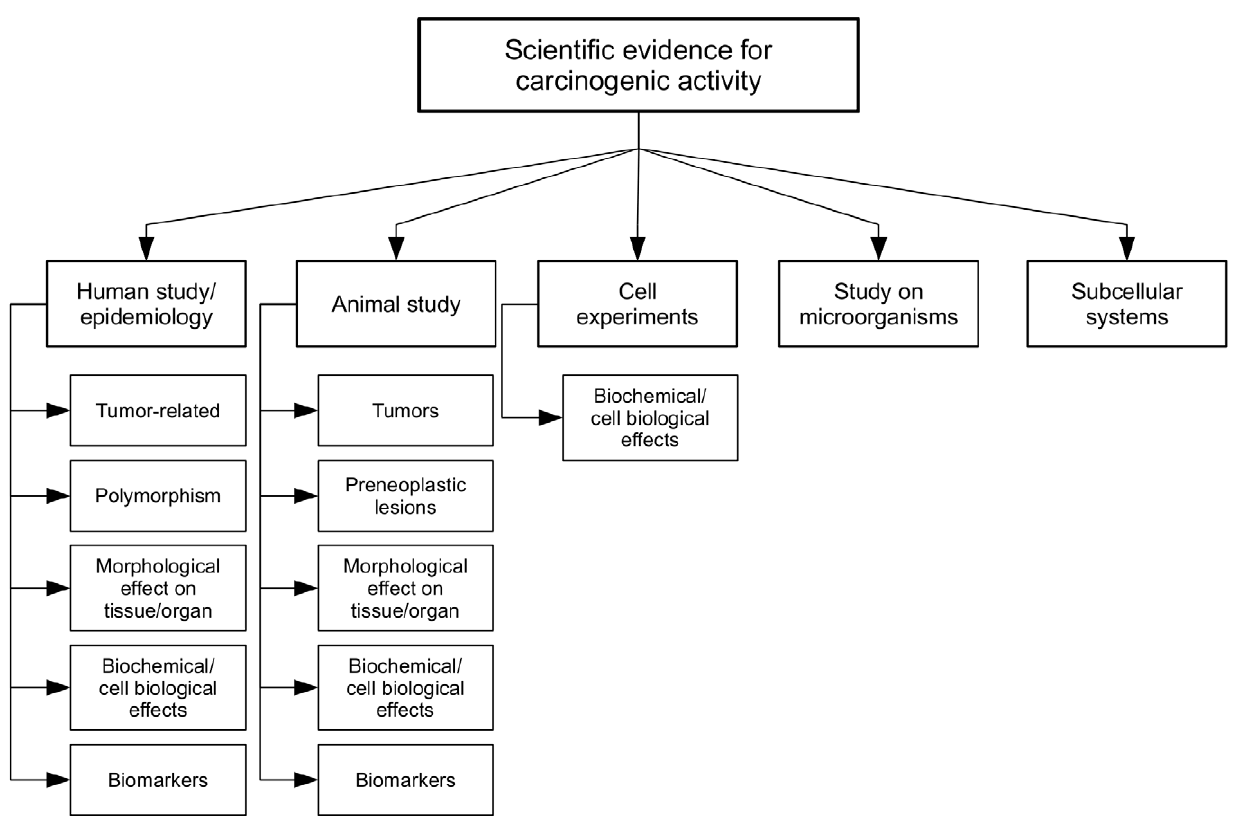
Figure 1. The ScientificEvidenceforCarcinogenicActivity taxonomy branch.